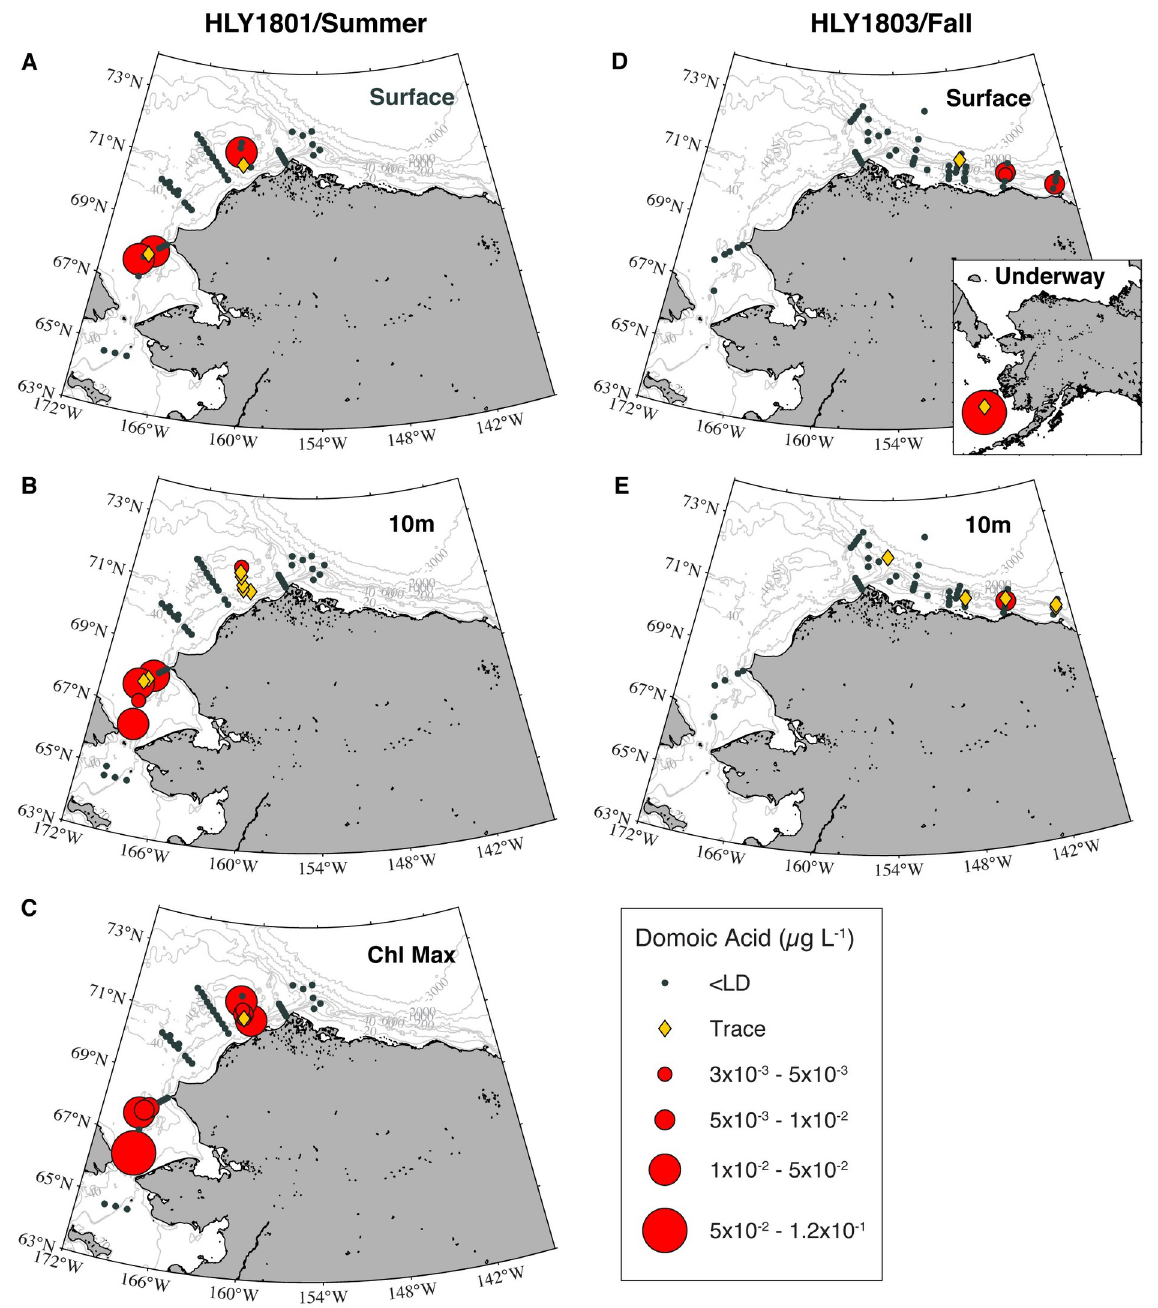
Fig 7. Distribution of particulate domoic acid. Concentrations of DA (ng L -1 ) detected during summer/ Healy 1801 at surface (A) 10 m (B) and chlorophyll maximum (C) depths, and during fall/ Healy 1803 at surface (D) and 10 m (E) depths. Inset in panel D displays two underway samples collected on the return transit of the fall